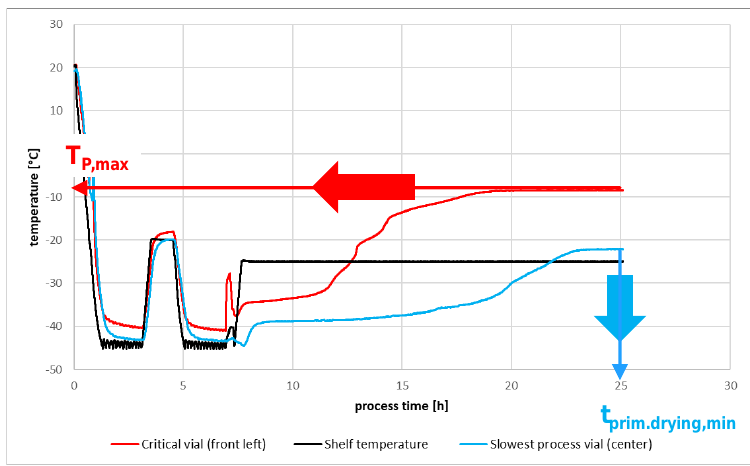
Figure 2. Product temperature for the critical vials. Highest heat input ( corner vial )-red: defines maximum shelf temperature; minimum heat input ( center vial )-blue: defines minimum process time.